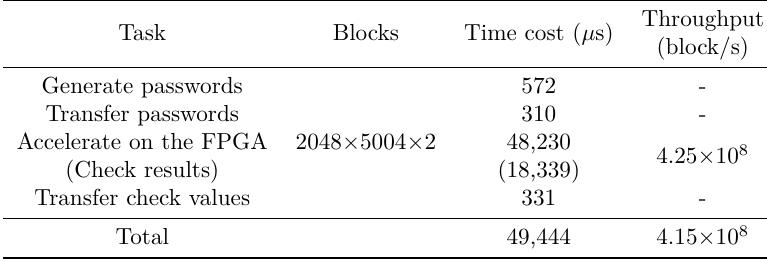
Table 5: Time cost for a group of 2048 passwords when LP = 6 bytes.